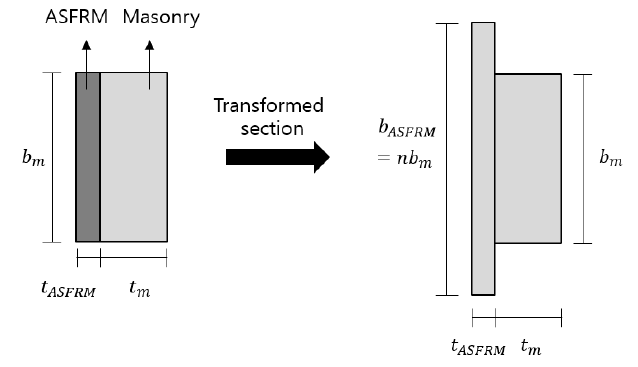
Figure 12. Transformed section of prisms strengthened on one side.